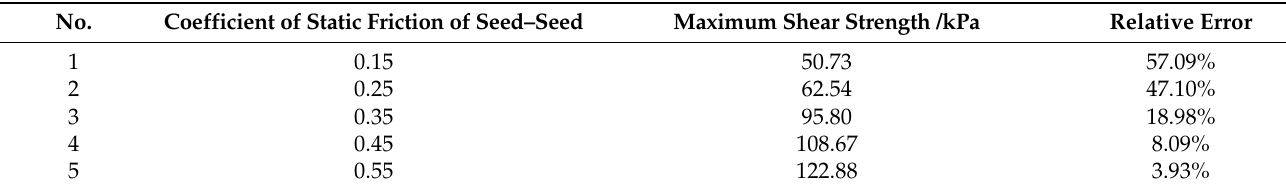
Table 10. Arrangement and results of the path of steepest ascent method.